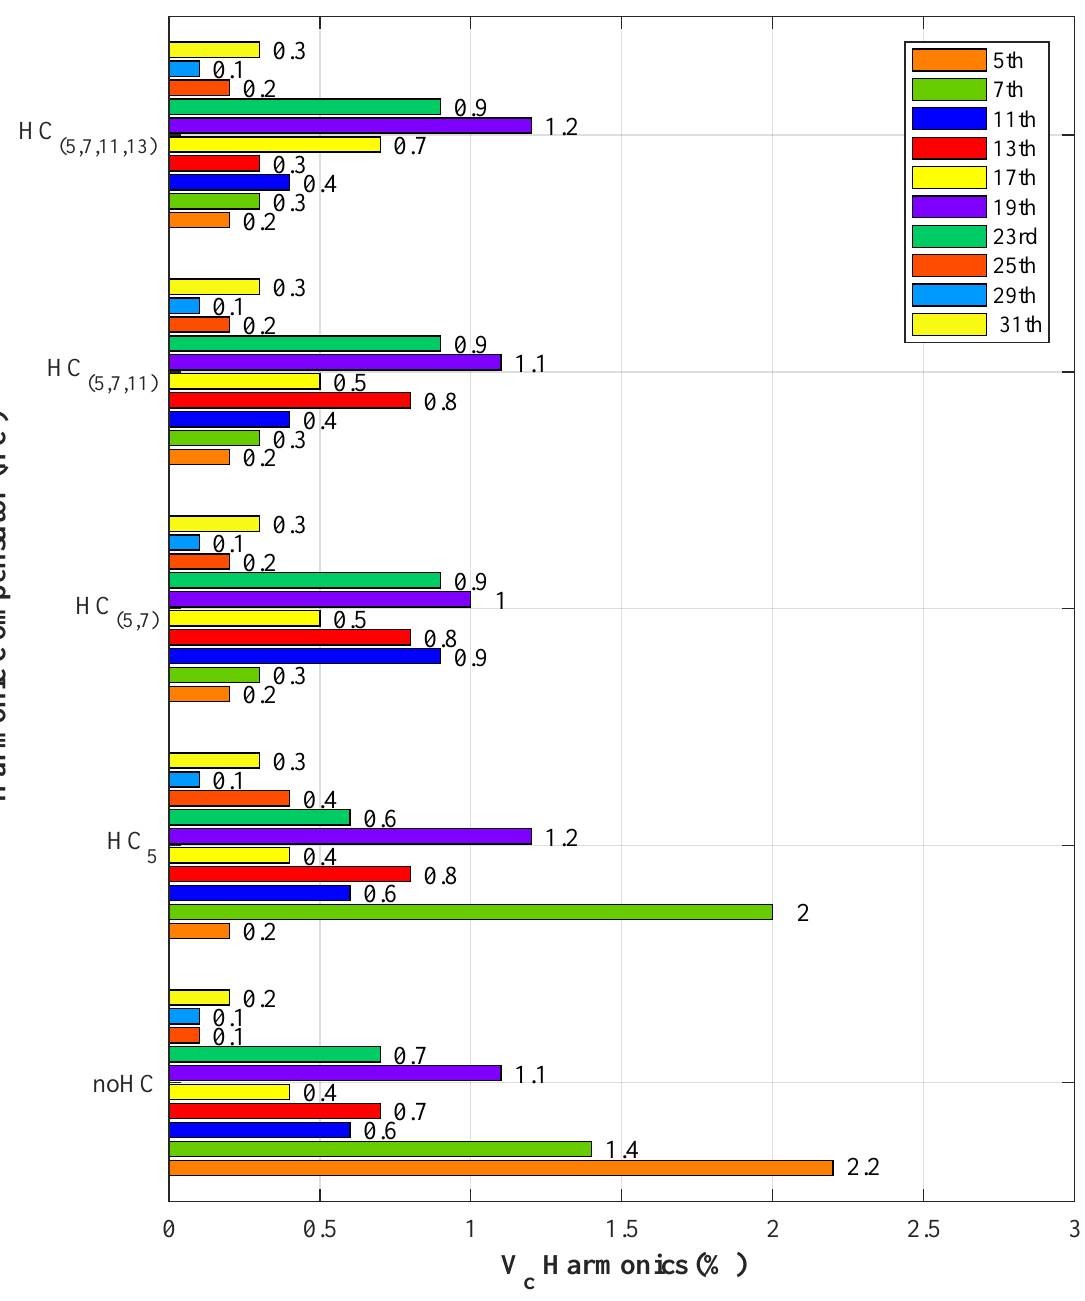
Figure 22. Harmonic V c content controlled by dSPACE Scalexio